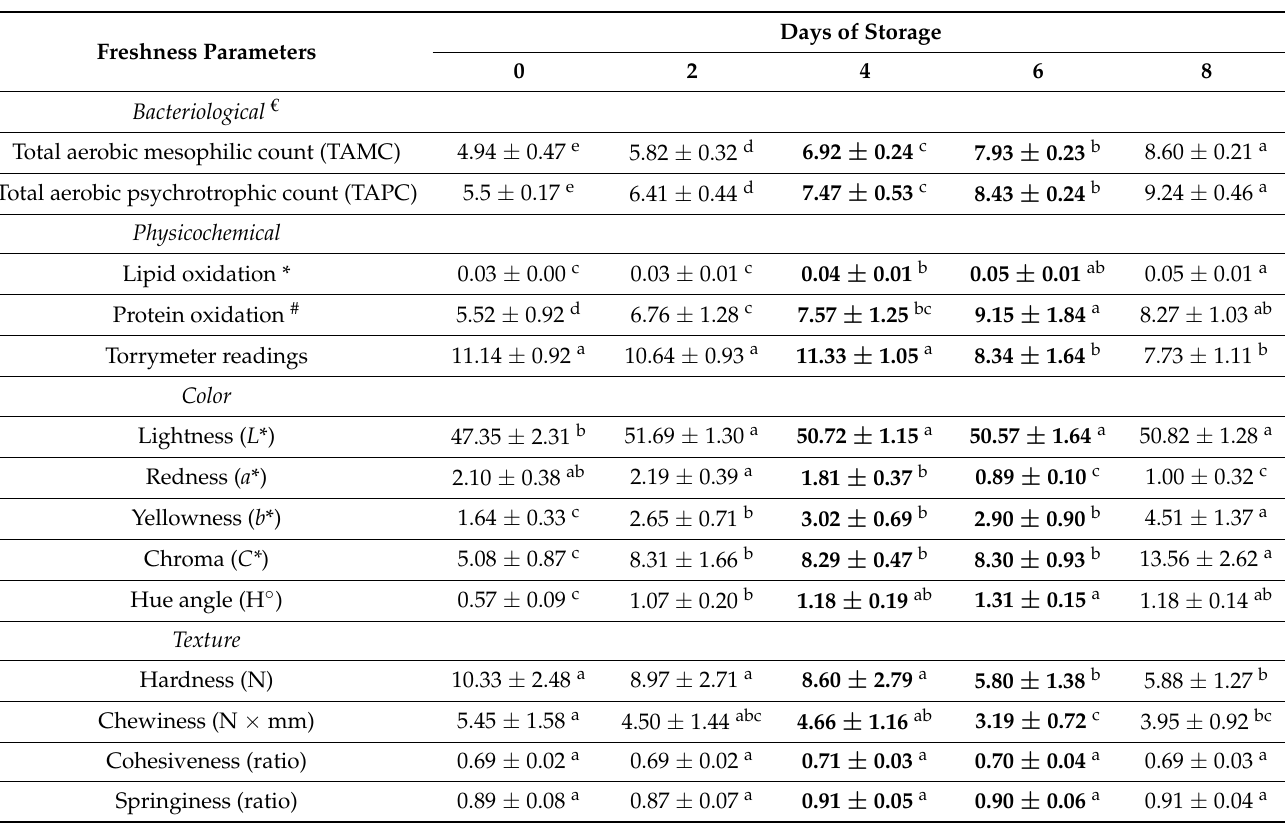
Table 2. Freshness parameters of Nile tilapia ( Oreochromis niloticus ) fillets stored at 4 ± 1 ◦ C for 8